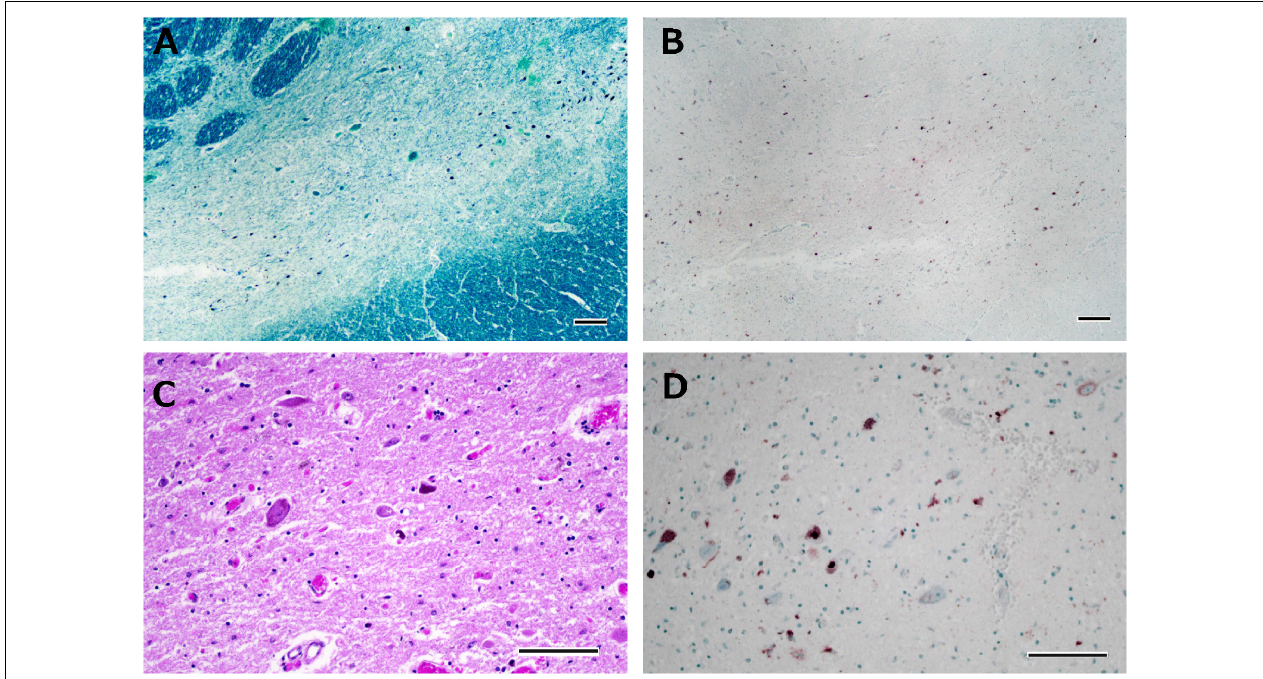
FIGURE 7 | Histological observations of the substantia nigra from Case 4. Neuronal loss is observed in the intermediate portion of the substantia nigra (A) , where phosphorylated TDP-43-positive structures are depicted (B) . Astrogliosis is moderately severe (C) , and phosphorylated TDP-43-positive neuronal inclusions and dot-like deposits are identified (D) . Klüver-Barrera staining (A) , immunostaining for phosphorylated TDP-43 (B,D) , and hematoxylin-eosin staining (C) . Scale bars: 200 µ m (A,B) and 100 µ m (C,D)